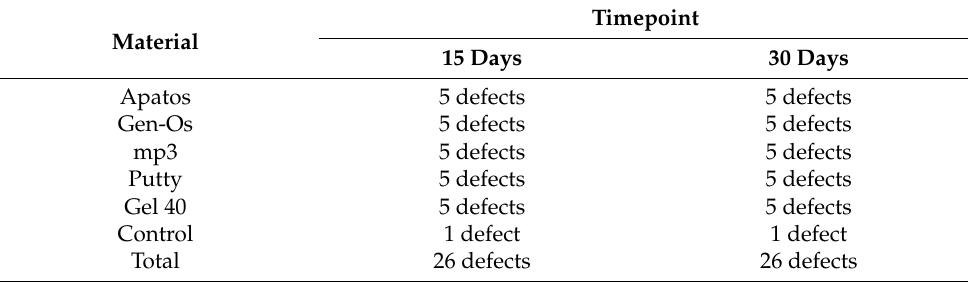
Table 1. Allocation of tested